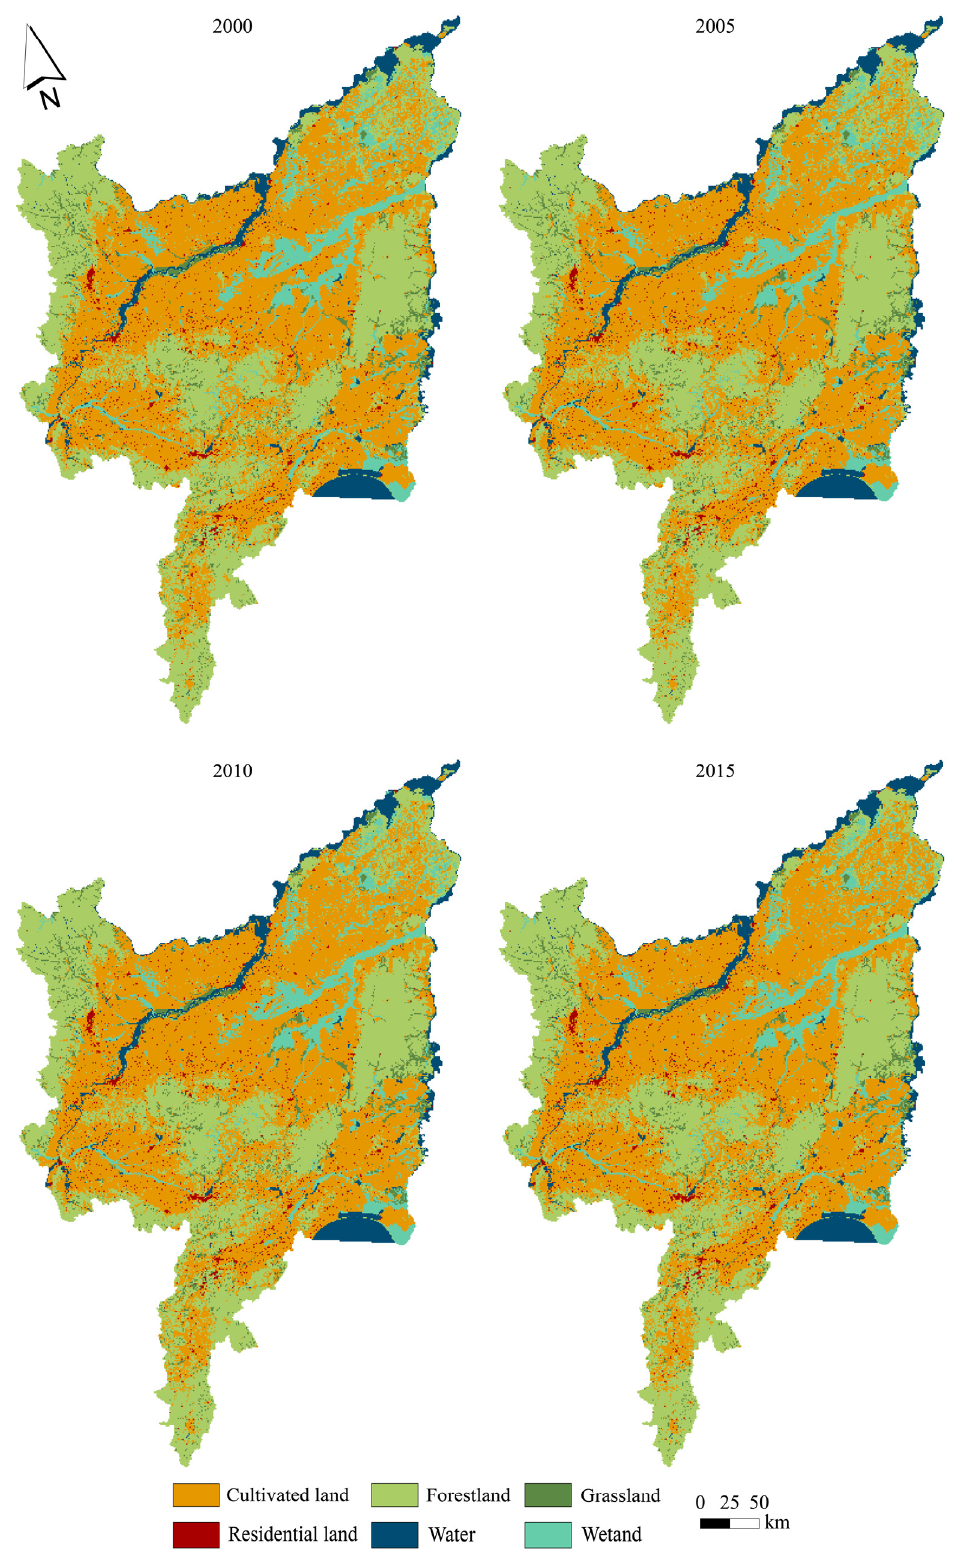
Figure 4. Spatial distribution of land use type.